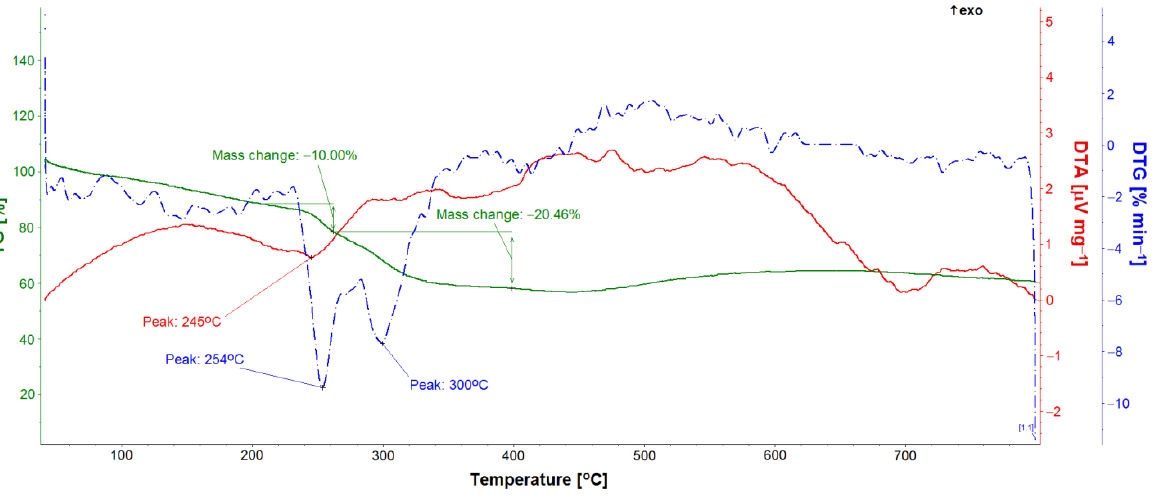
Figure 13. TG, DTA, and DTG curves of gentamicin sulfate-loaded ONTs.